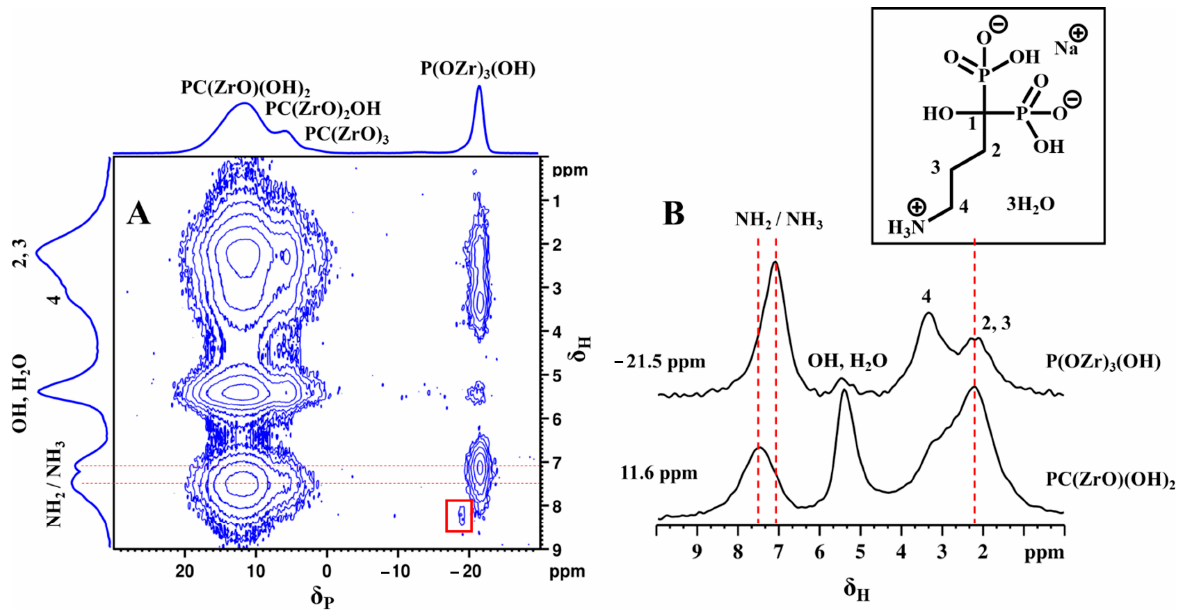
Figure 10. 2D 31 P– 1 H FSLG HETCOR NMR spectrum ( A ) of α ZP2 at MAS rate of 13,840 Hz. 1 H NMR spectra obtained from the individual columns (extracted slices) corresponding to − 21.5 and 11.6 ppm 31 P resonances of the 2D spectrum ( B ). Inset shows the molecular structure of ALN-Na.